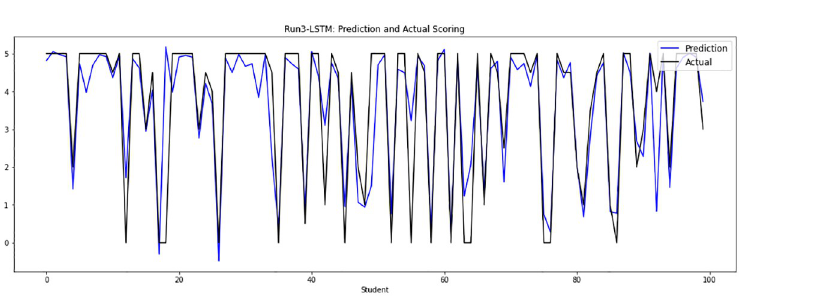
Fig 8. LSTM-GWO prediction and actual scores with experiment 3.